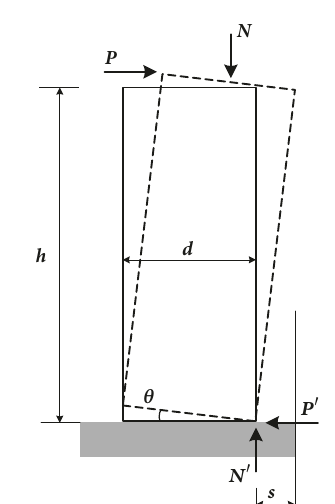
Figure 9: Rotational deformation of rigid column.